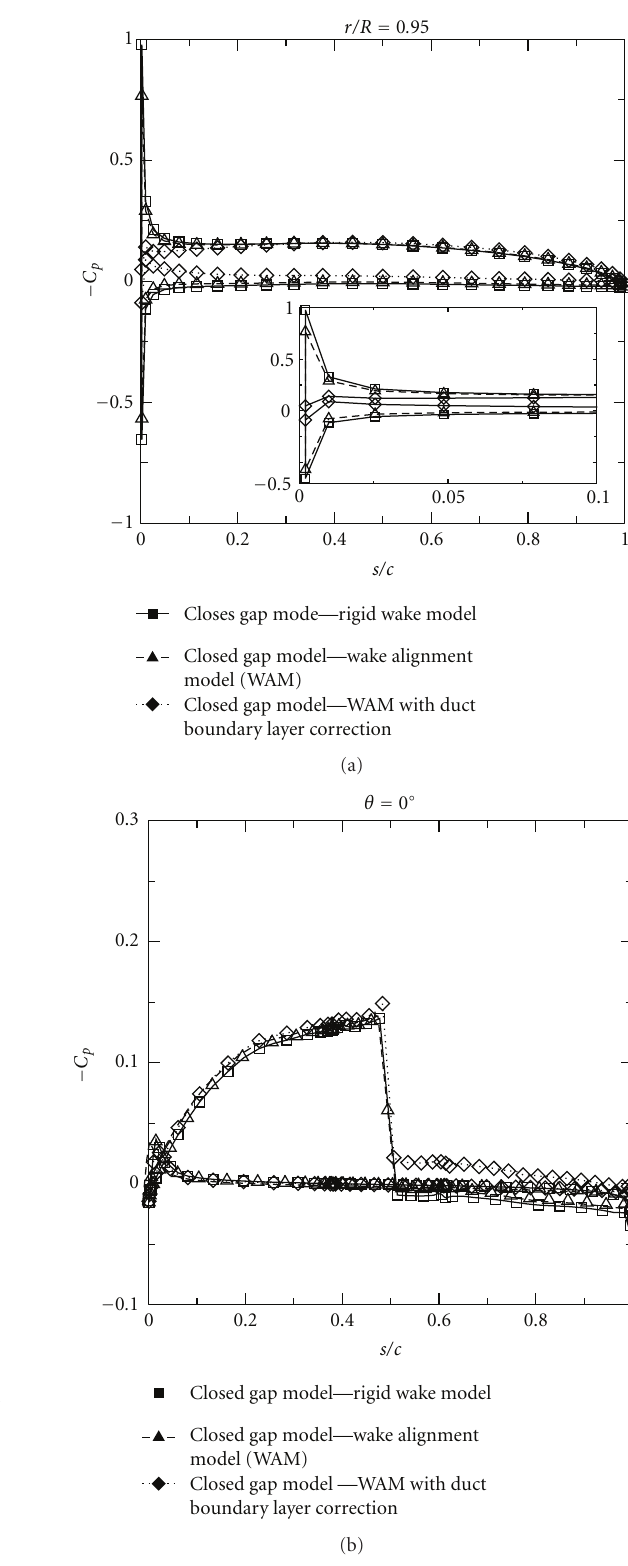
Figure 13: Blade chordwise pressure distribution at r/ R = 0 . 95 (a). Duct chordwise pressure distribution at θ = 0 degrees (b). Influence of wake model. Ka4-70 inside duct 19Am at J = 0 . 5. Closed gap